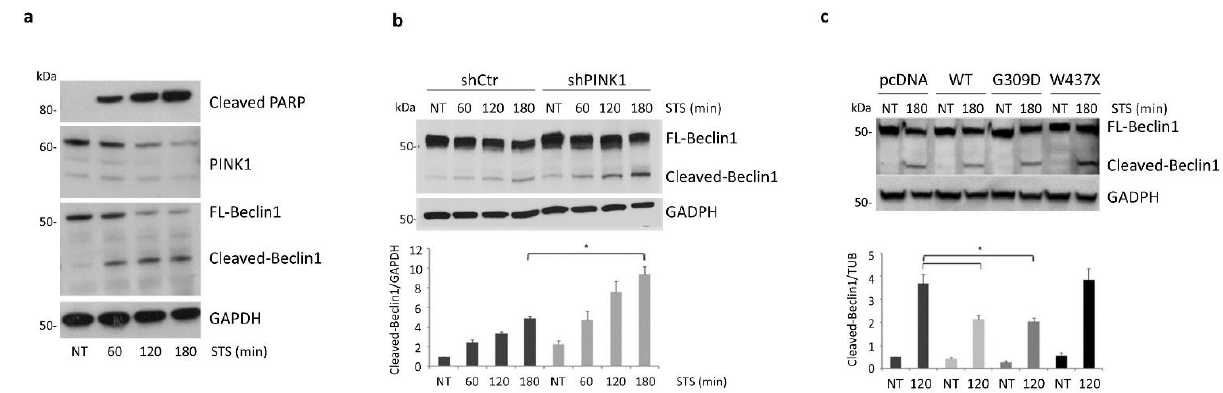
Figure 7. PINK1 protects against Beclin1 pro-apoptotic cleavage in response to STS treatment. ( a ) SH-SY5Y overexpressing PINK1-HA and Beclin1-Myc were treated either with STS (for 1, 2 and 3 h) or with DMSO for 3 h (NT). The progressive formation of the pro-apoptotic fragment of Beclin1 (cleaved-Beclin1) in response to STS treatment was visualized by immunoblotting with the anti-Myc antibody. PINK1 expression was verified by immunoblot analysis with an anti-PINK1 antibody. Equal loading was verified by GAPDH protein levels; ( b ) SH-SY5Y cells stably overexpressing Beclin1-Myc were transduced with PINK1-shRNA (shPINK1) or control-shRNA (shCtr) and then treated either with STS (for 1, 2 and 3 h) or with DMSO for 3 h (NT). Immunoblotting analysis of the caspase-cleaved fragment of Beclin1 (detected by Myc immunostaining) revealed a significant increase in the pro-apoptotic fragment at 180 min of STS in shPINK1 compared to shCtr cells (4.87 ± 0.19 versus 9.34 ± 0.76, p = 0.0047). Equal loading was verified by GAPDH protein levels; ( c ) PINK1-silenced (shPINK1) SH-SY5Y cells were transiently transfected with empty vector (pcDNA), PINK1 wild type (WT), PINK1 G309D or PINK1 W437X (together with Beclin1-Myc), and then treated either with STS or with DMSO for 2 h (NT). Beclin1 cleavage was assessed by immunoblotting analysis with the anti-Myc antibody. Equal loading was verified by GAPDH protein levels. Complementation with both WT-PINK1 and the G309D mutant significantly reduced Beclin1 cleavage induced by STS exposure, whereas the PINK1 W437X mutant exhibited levels of cleaved Beclin1 similar to those observed in pcDNA-transfected cells (3.92 ± 0.96 versus 4.03 ± 1.04). *p ≤ 0.05.